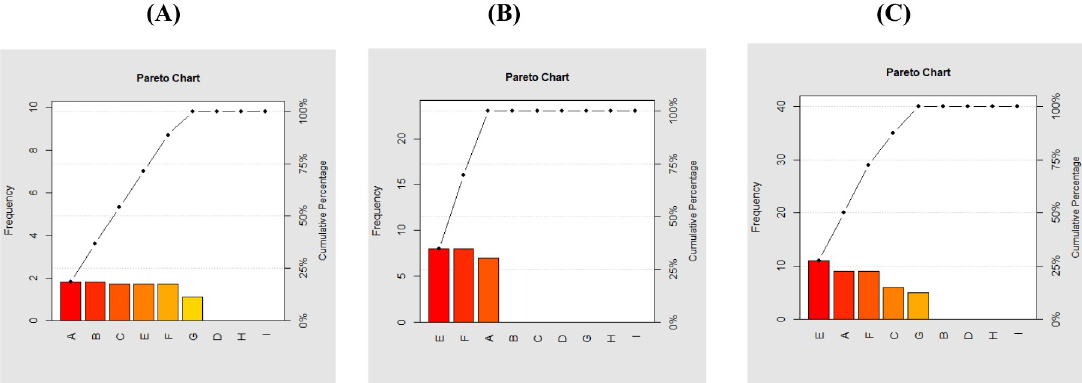
Fig 5. The above chart output displays the frequency and cumulative frequency of each (A) NPs; (B) Fe. Ions and (C) Plants.